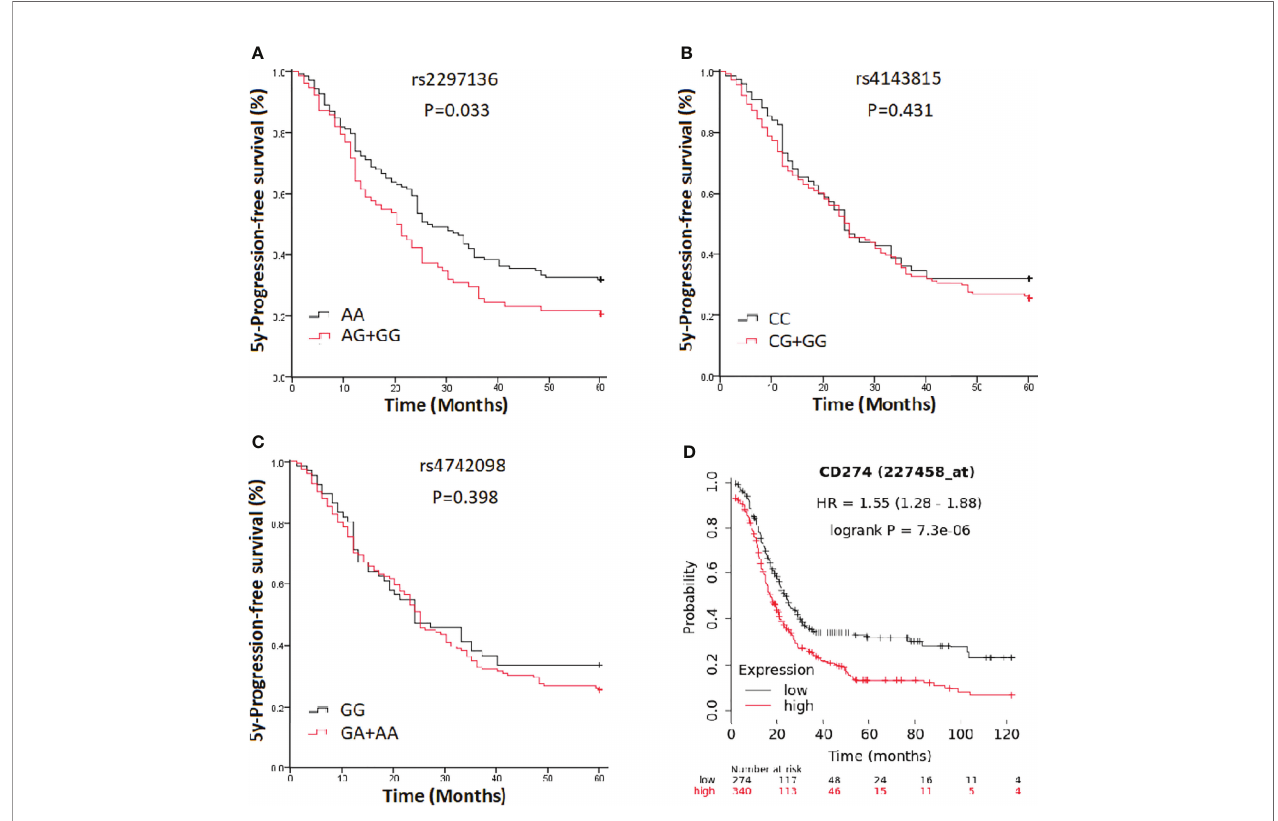
FIGURE 1 | Kaplan-Meier estimate of progression-free survival (PFS) in epithelial ovarian cancer patients categorized by PD-L1 polymorphisms. (A) rs2297136; (B) rs4143815; (C) rs4742098; (D)